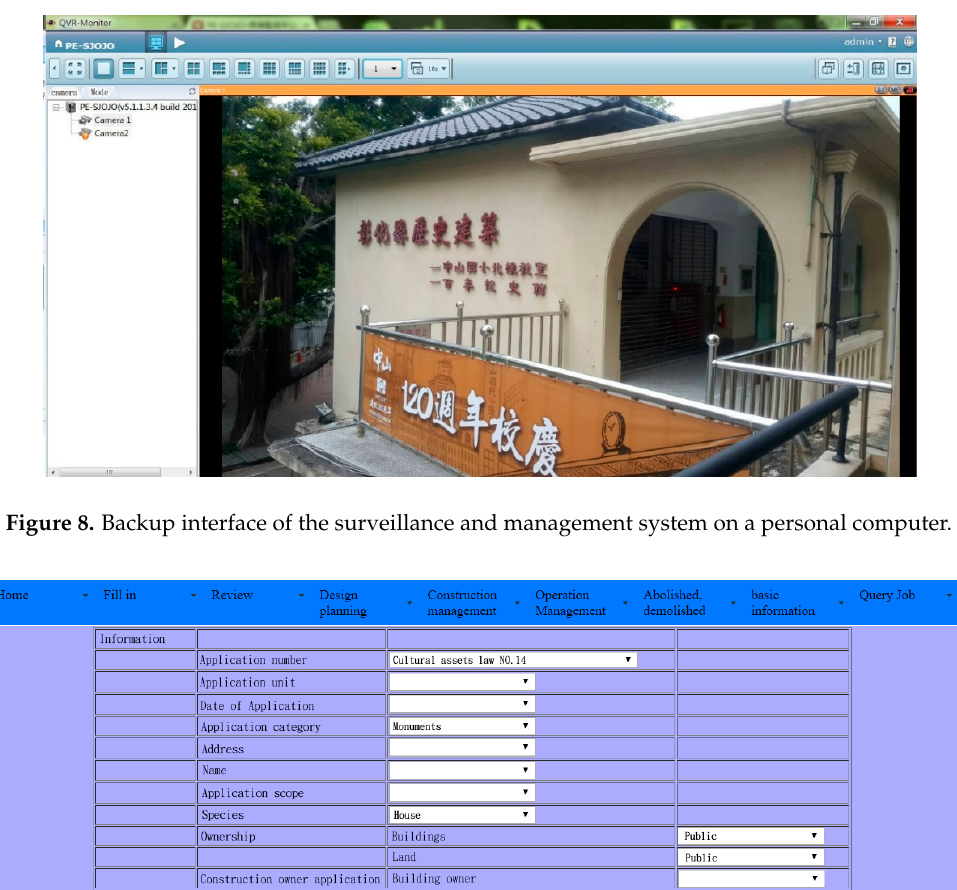
Figure 7. Panorama of a site displayed on a mobile device.